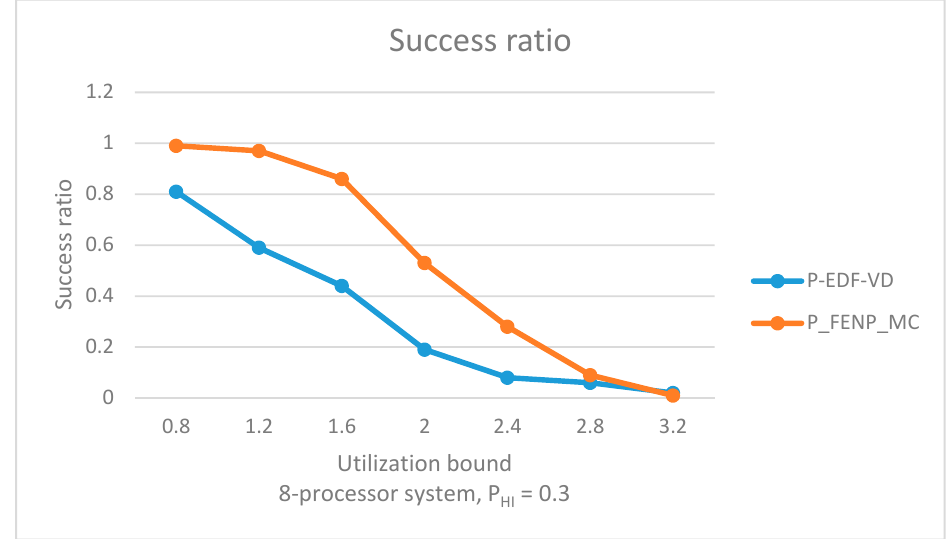
Figure 8. Success ratio by varying the utilization bound. 𝑈 (cid:3013) = 0.05,𝑈 (cid:3022) = 0.75, 𝑍 (cid:3013) = 1, 𝑍 (cid:3022) = 4 .